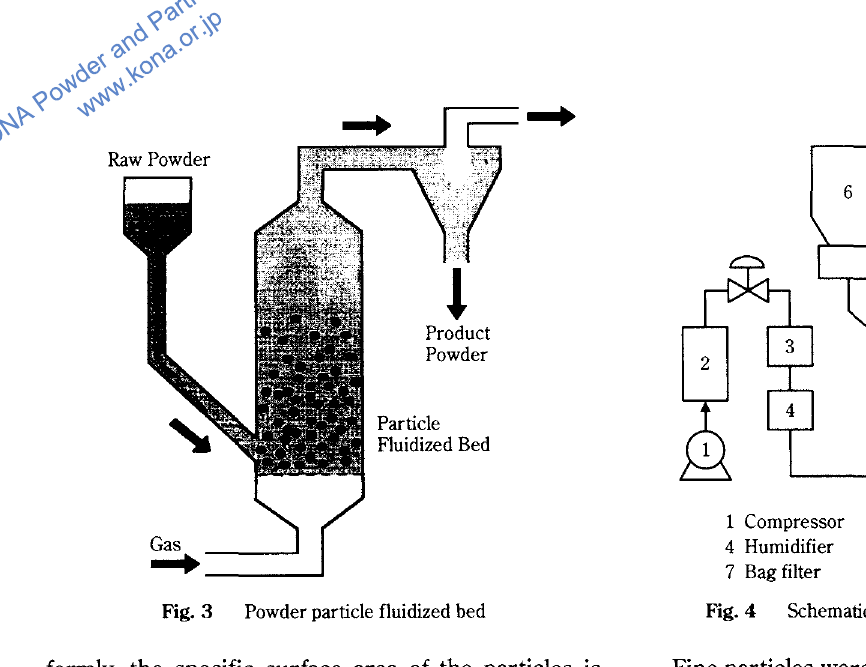
Fig. 3 Powder particle fluidized bed Fig. 4 Schematic diagram of the experimental apparatus Fine particles were continuously fed into the bed and fluidized with coarse particles, then elutriated from the bed. The elutriation rate of fine particles from the bed was measured by weighing the bag filter at cer tain time intervals. Once the elutriation rate of fine particles became constant, the system was consid ered to have achieved a steady state. At this point the feeds of both air and fine particles were immediately stopped, and the mixture of fine and coarse particles in the bed was removed to measure the content of fine particles, which was determined by separating the fine particles from the mixture in water. Most of the fine particles in the bed had adhered to the surfaces of coarse particles. But some fine parti cles in the bed had agglomerated into secondary par ticles with sizes of 50-200 ,urn. The amount of these agglomerated particles was determined by the follow ing procedure. The small amount of bed particles was screened with a sieve that had a smaller mesh size than the size of the coarse particles. Most of the agglomerated particles were screened out. Their weight was obtained by weighing the sample before and after screening. The holdup of fine particles X was calculated from Eq. (1) by measuring the total weight of fine particles WP and total weight of